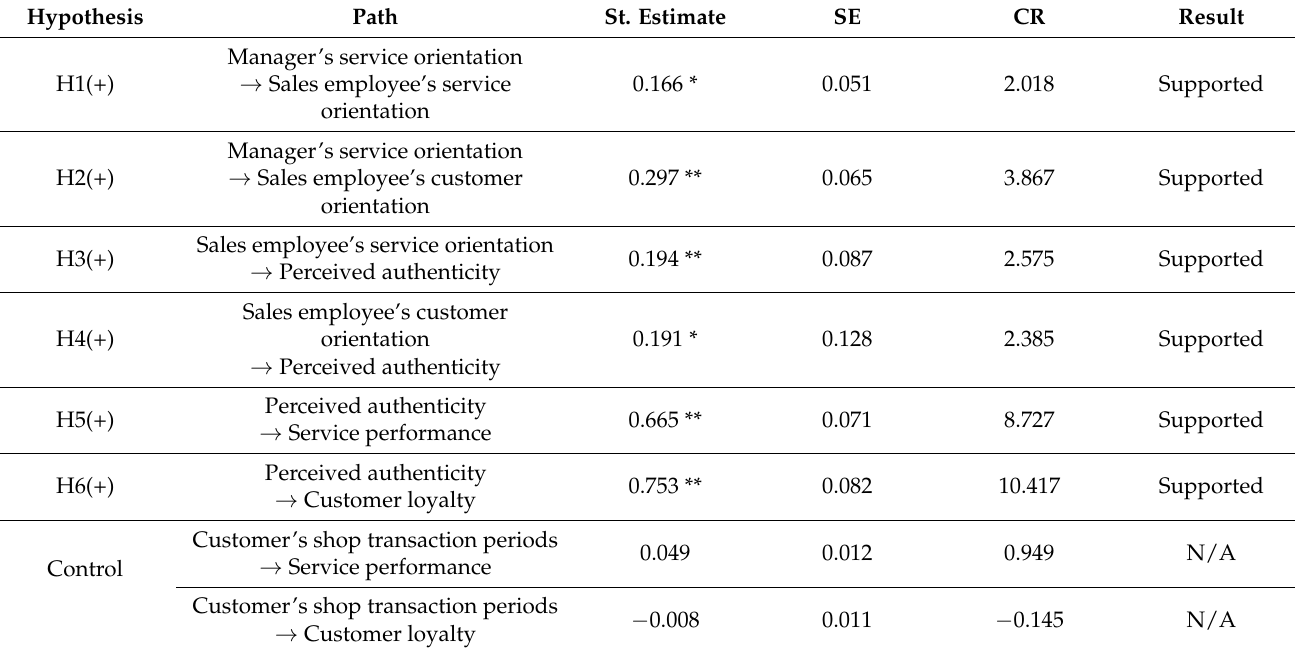
Table 4. Results of the hypothesis